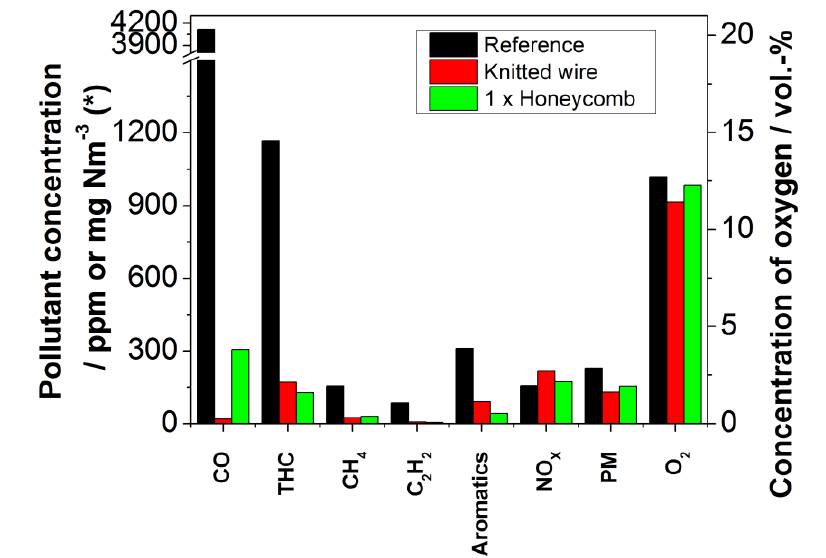
Figure 6. Comparison of the concentrations of selected pollutants and of oxygen in the exhaust stream without catalyst and with the two tested catalysts (black bars: without catalyst; red bars: knitted wire catalyst, green bars: honeycomb catalyst; * The measurement unit of the particulate matter concentration is mg Nm −3 and for all other pollutants ppm).